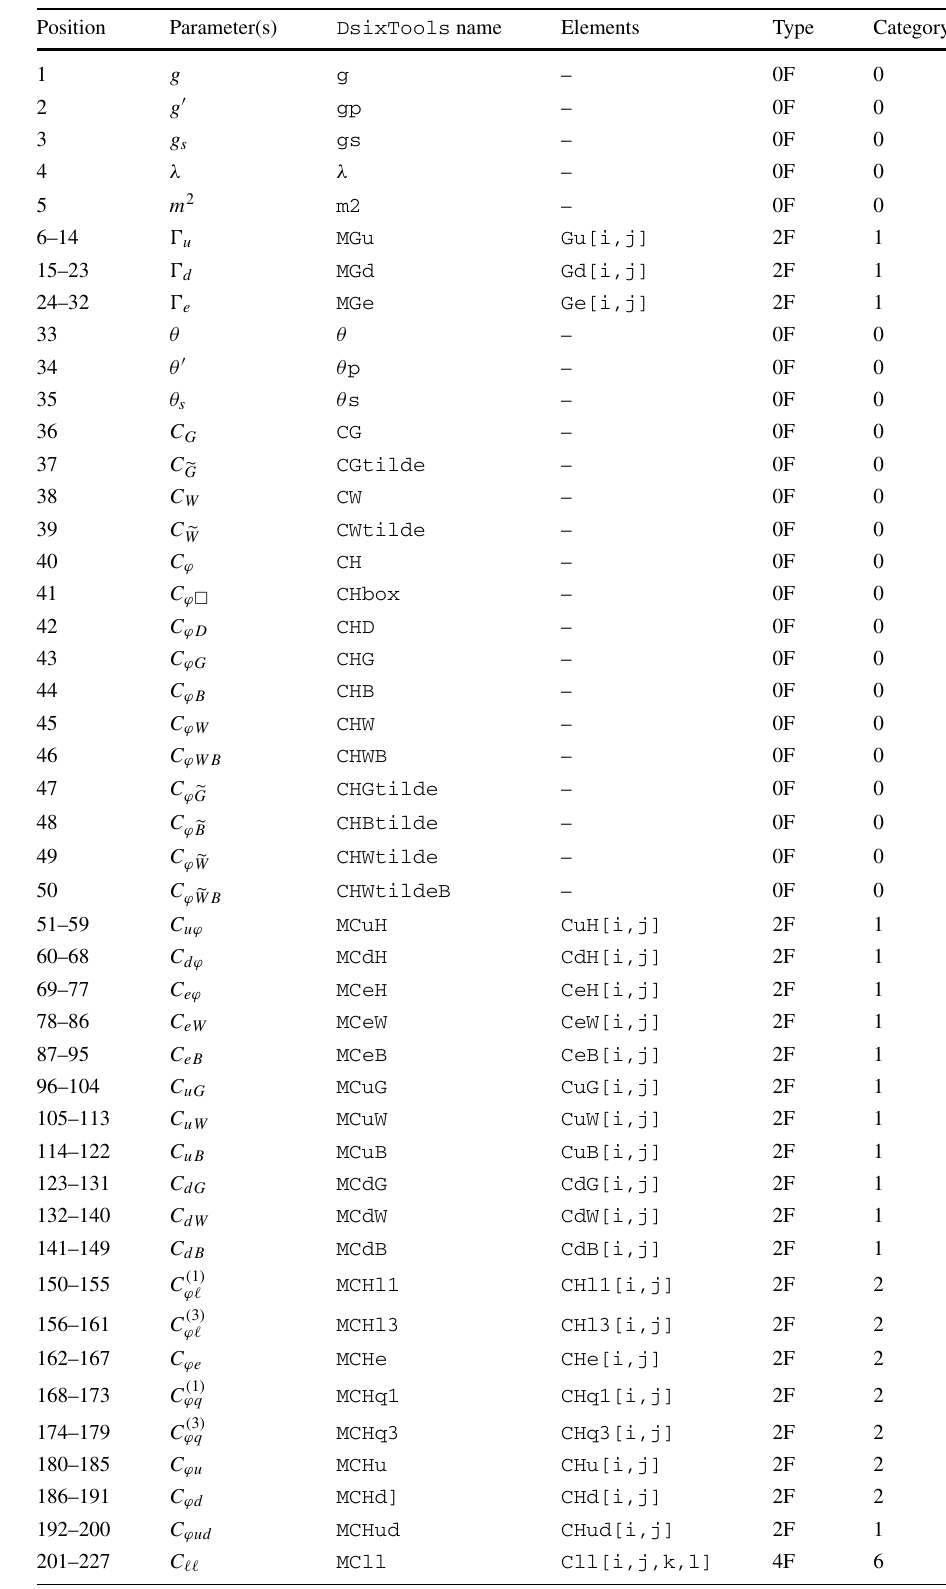
Table 17 SMEFT parameters. Position denotes the position of the parameter (or parameters for 2- and 4-fermion objects) in the SMEFTParametersTotal global array. Type indicates the type of parameter (with nF standing for n-fermion) and Category denotes the index symmetry category of the coefficient, being relevant for 2- and 4-fermion